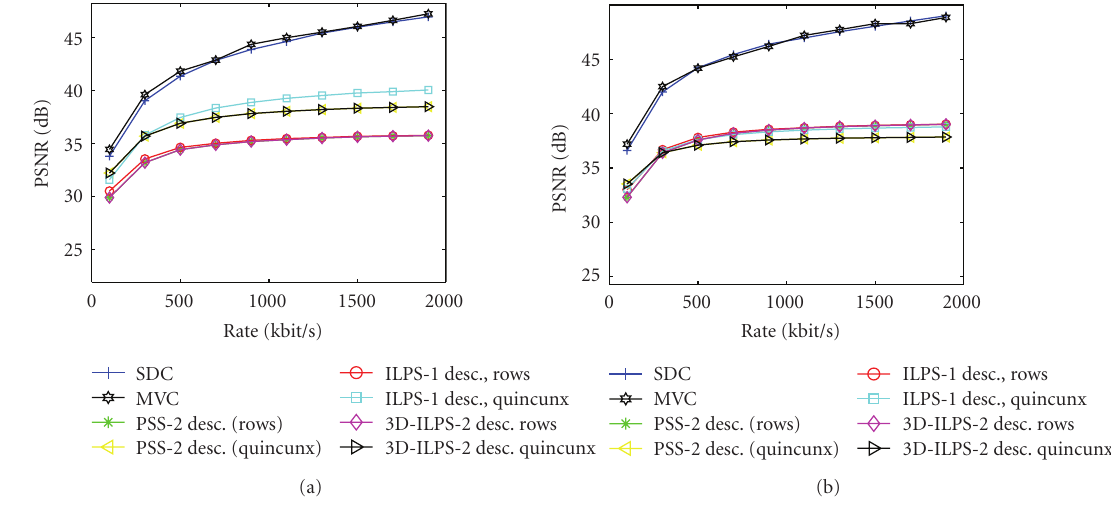
Figure 7: Performance of left view, two subsequences received. (a) Breakdance. (b) Ballet.